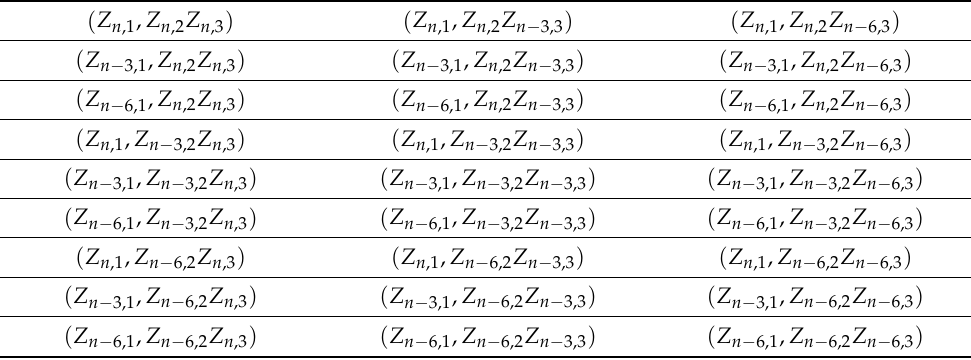
Table 2. Illustrative example of combinations